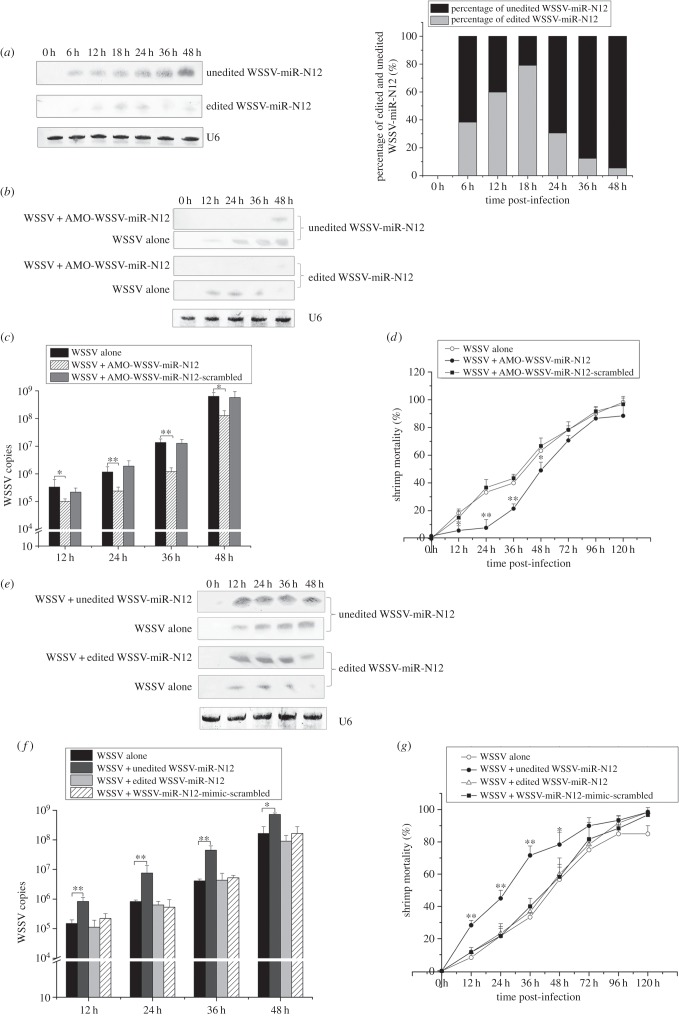
(Overleaf.) The role of viral miRNA editing in virus latency. (a) Viral miRNA detected in shrimp infected with WSSV. The expressions of edited and unedited WSSV-miR-N12 were examined by northern blot pre-infection (0 h), and post-infection (6, 12, 18, 24, 36 and 48 h). The percentages of edited and unedited viral miRNA were evaluated. (b) The silencing of viral miRNA expression. The expression of WSSV-miR-N12 in WSSV-infected shrimp was silenced by AMO-WSSV-miR-N12. The silencing was examined by northern blot pre-infection (0), and 12, 24, 36 and 48 h post-infection. U6 was used as a control. (c) Effects of WSSV-miR-N12 on the WSSV replication in shrimp. Shrimp were simultaneously injected with WSSV and AMO-WSSV-miR-N12. WSSV alone and AMO-WSSV-miR-N12-scrambled were used as controls. The shrimp were subjected to real-time PCR to detect the WSSV copies 12, 24, 36 and 48 h post-infection. The numbers indicated the time points post-infection. (d) Cumulative mortalities of WSSV-challenged shrimp after the injection of AMO-WSSV-miR-N12. Each point represented the mean of triplicate assays. (e) The overexpression of viral miRNA. The edited and unedited WSSV-miR-N12 mimics were co-injected with WSSV into shrimp, respectively. Edited and unedited WSSV-miR-N12 were detected pre-infection (0), and 12, 24, 36 and 48 h post-infection by northern blots. U6 was used as a control. (f) The shrimp were simultaneously injected with WSSV and the unedited or edited WSSV-miR-N12, and the WSSV copies in shrimp were monitored by quantitative real-time PCR at 12, 24, 36 and 48 h post-infection (g) The accumulative mortalities of WSSV-infected shrimp treated with the unedited or edited WSSV-miR-N12 were monitored 1–5 days post-infection. All the assays were repeated three times (*p < 0.05; **p < 0.01).